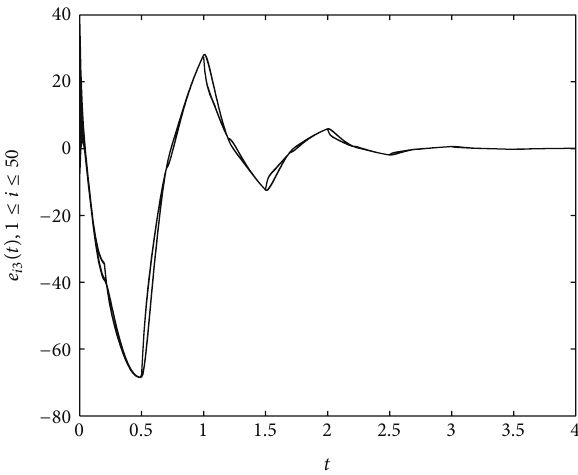
Figure 3: Synchronization errors 𝑒 𝑖 2 , 1 ≤ 𝑖 ≤ 50, with control parameters 𝑘 = 5, 𝑇 = 0 . 5, and 𝜃 = 0 . 8.